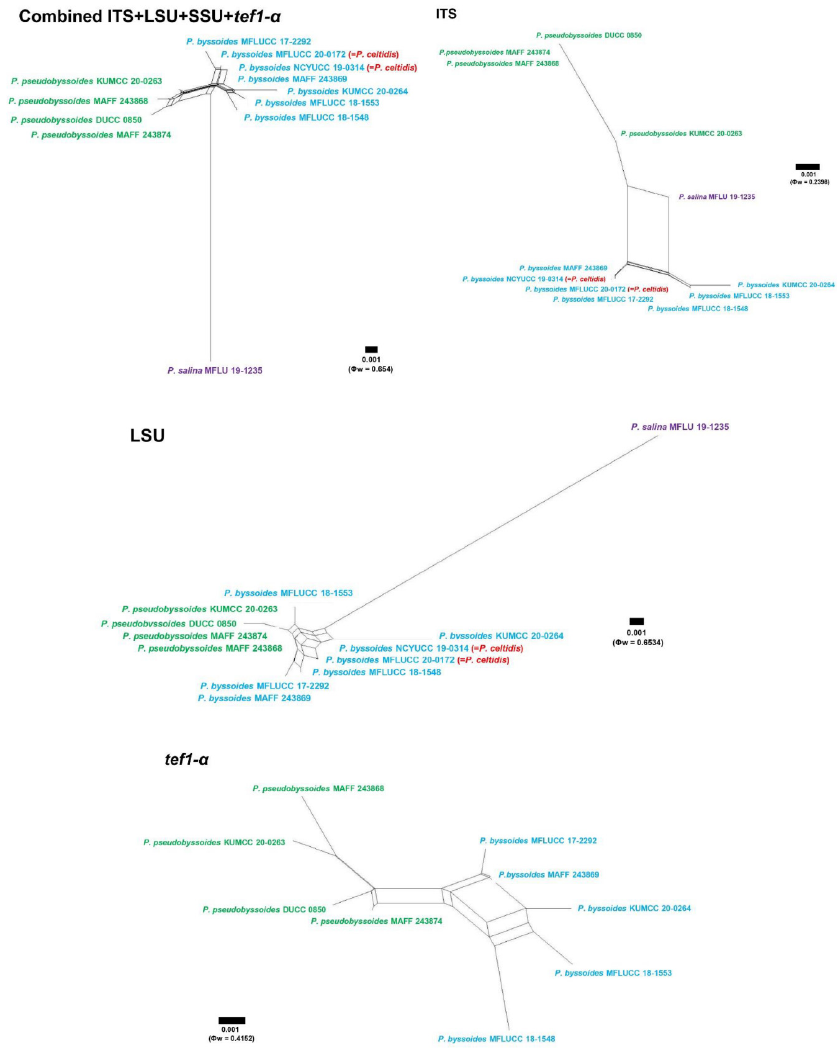
Figure 2. Split graphs showing the results of the pairwise homoplasy index (PHI) tests of closely related taxa using LogDet transformation and split decomposition. PHI test results ( Φ w) ≤ 0.05 indicate significant recombination within the dataset.